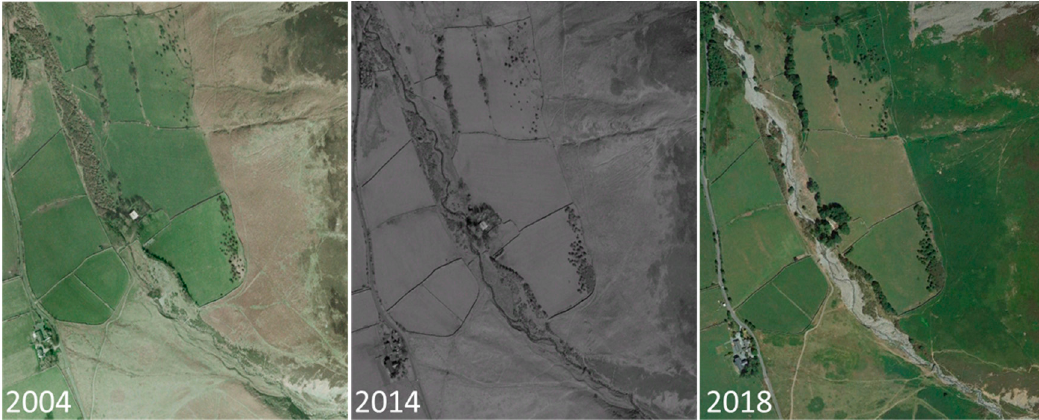
Figure 4. Historic image mapping of the Liza Beck at Langthwaite, Cumbria, UK. Original image resolution 2004 0.6 m (Source Google Earth), 2014 0.5 m (Source Google Earth), 2018 0.02 m.